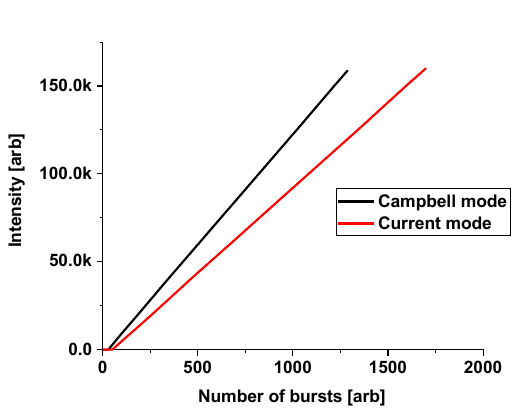
Fig. 11. Comparison of intensity measurement in Campbell and current modes demonstrates very good